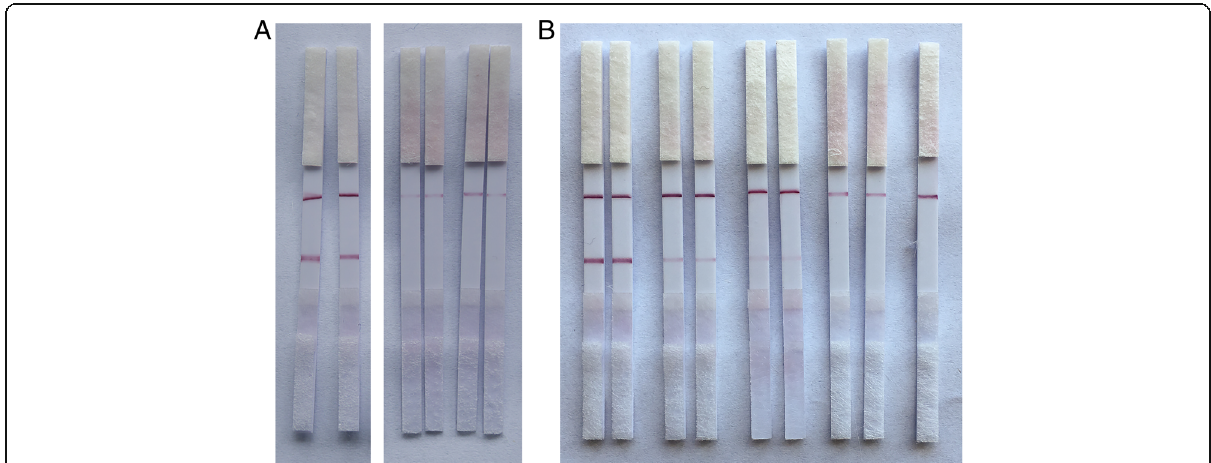
Fig. 5 Specificity ( a ) and sensitivity ( b ) of LFSA for rongalite. a 80 μ L of a rongalite solution (10 μ g/mL) was added to the sample pad of the